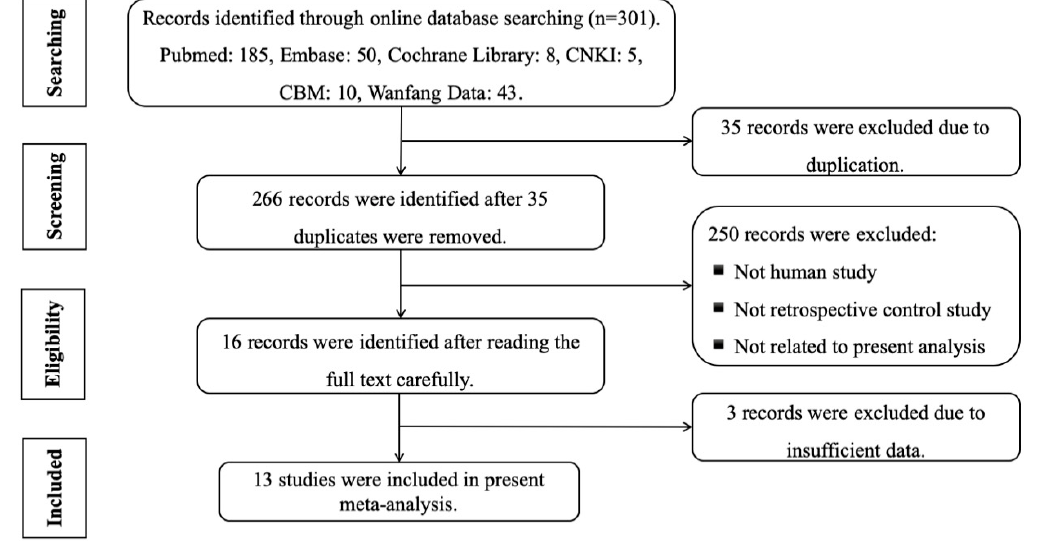
Figure 7. Flow diagram of literature search process.